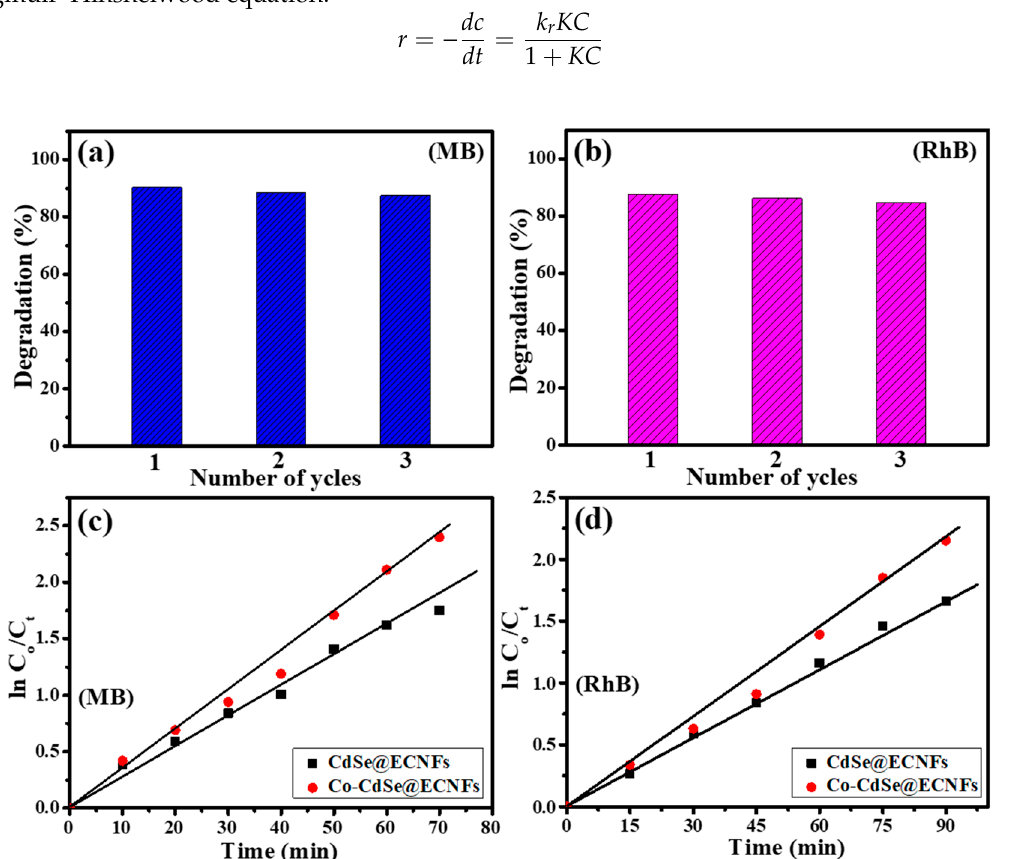
Figure 10. Cycling experiments of the photodegradation of ( a ) MB and ( b ) RhB solutions utilizing Co-CdSe@ECNFs. Photodegradation kinetics of ( c ) MB and ( d ) RhB solutions over different photocatalysts under visible light irradiation.